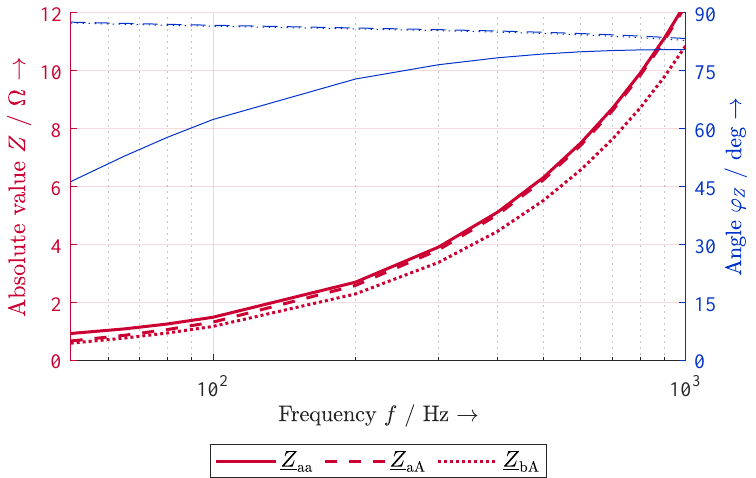
Figure 3. Calculated impedances of cable screens. (NA2XS2Y 1 × 150/25 12/20 kV, (cid:96) = 1km, triangular